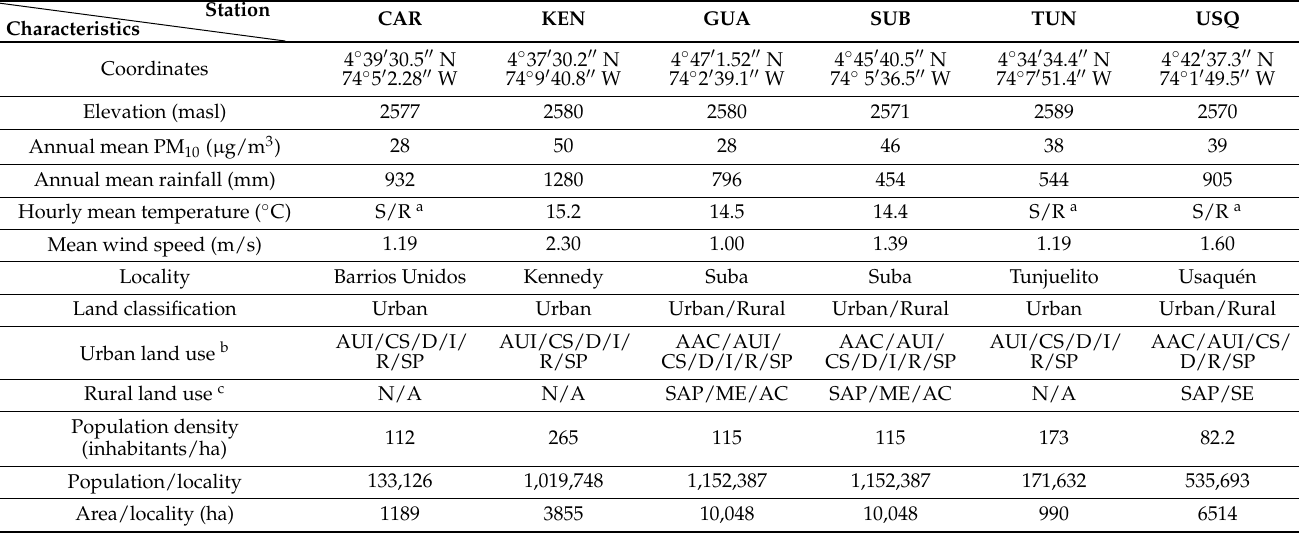
Table 1. Physical characteristics of the location areas of the established monitoring